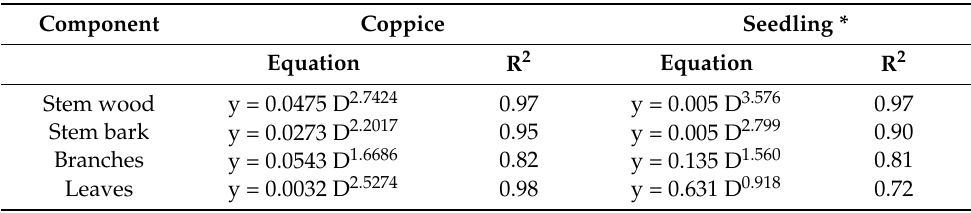
Table 1. Allometric relationships between stem diameter and biomass components of coppice and seedling stands of Eucalyptus pellita at age six